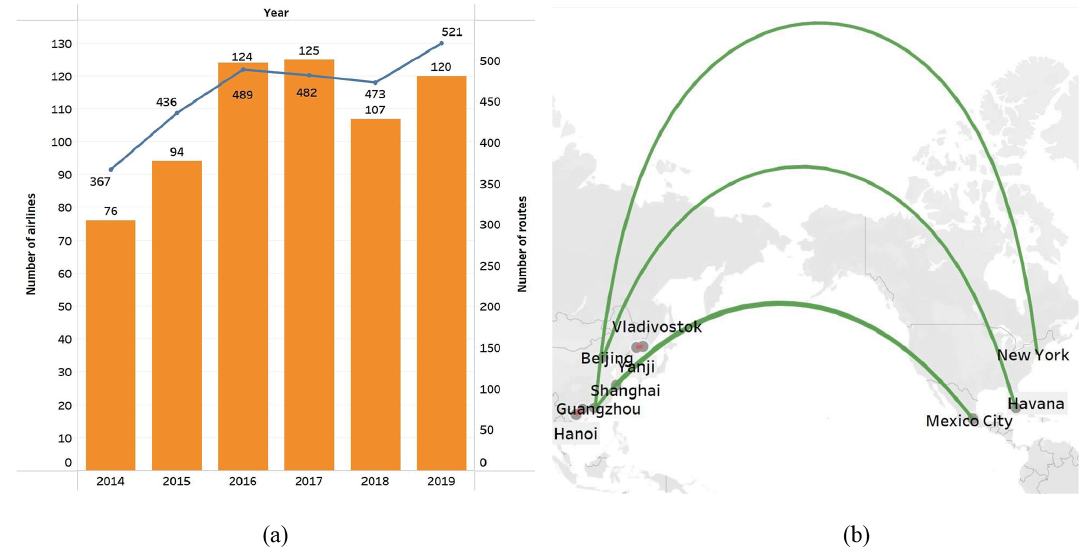
Figure 1. Statistical characteristics of the routes during 2014–2019. (a) Number of routes and number of airlines. (b) The longest and shortest distance.